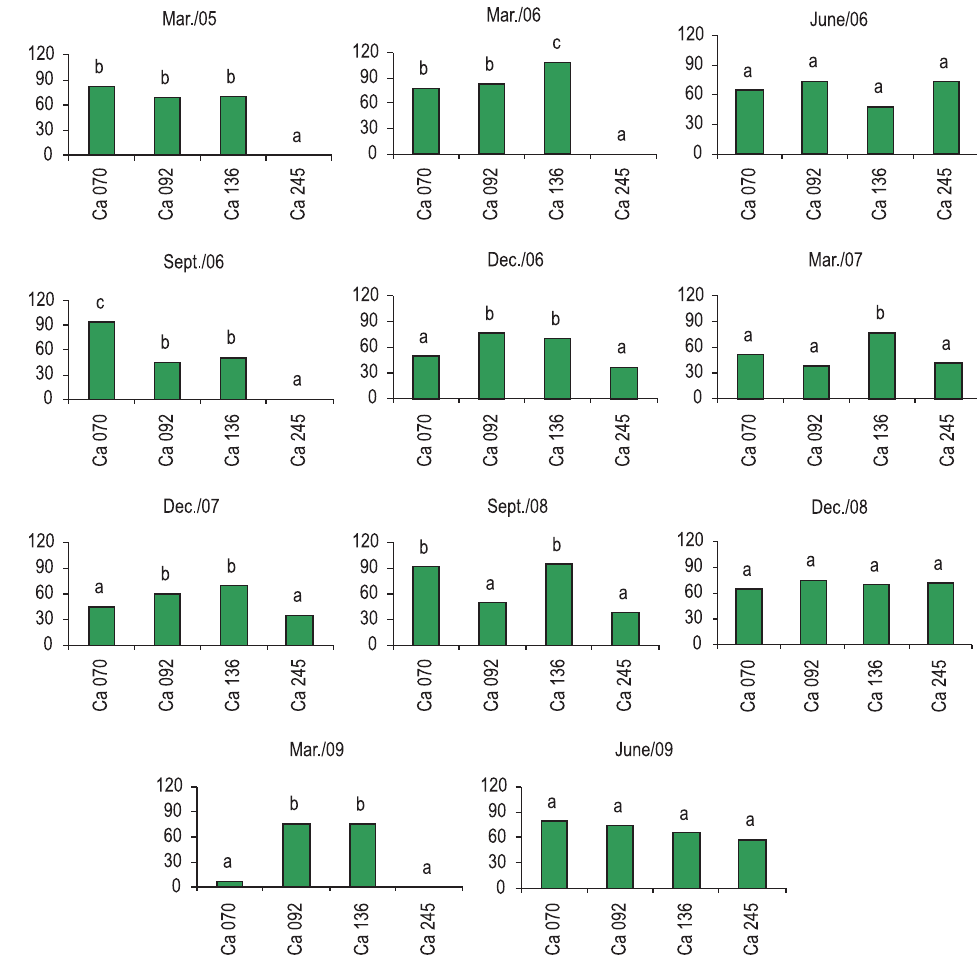
Figure 5. Mean number of neonates and comparison of the results between the sites using the Duncan Test. Same letter did not differ significantly by the LSD test (p ≤ 0.01).